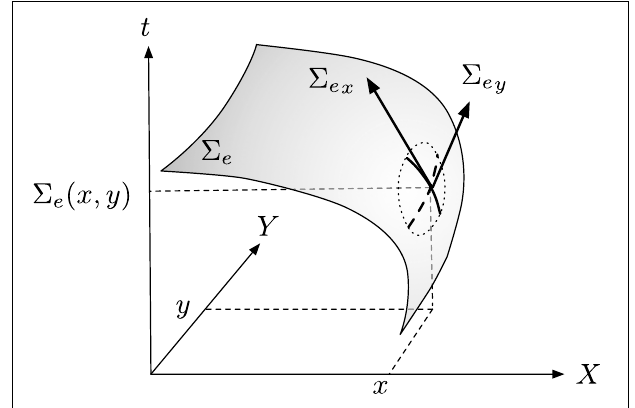
FIGURE 3 | General principle of visual flow computation, the surface of active events (cid:2) e is derived to provide an estimation of orientation and amplitude of